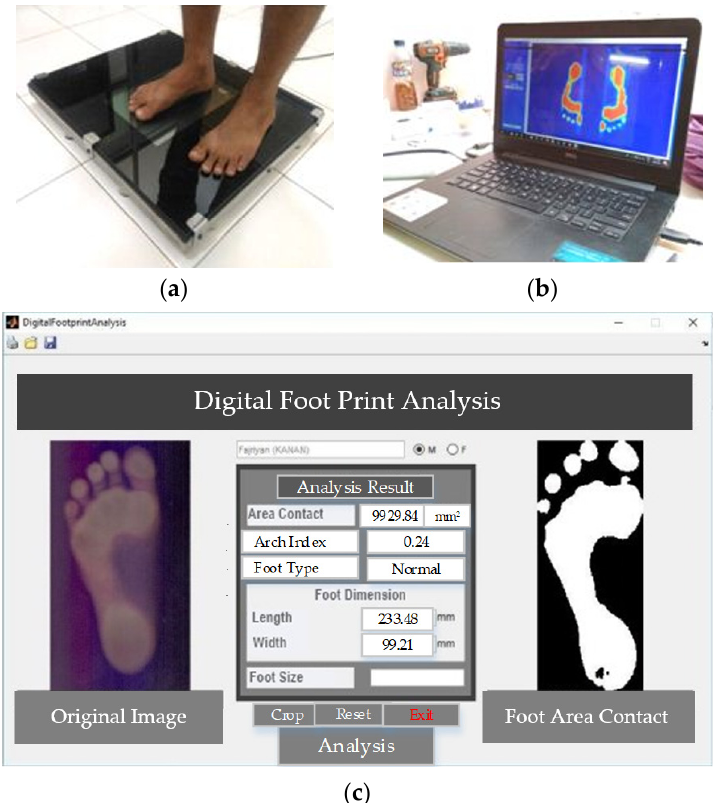
Figure 2. Digital AI measurement method: ( a ) footprint scanning; ( b ) image processing of the footprint using MATLAB;( c ) FL, FW, FAC, and AI results.